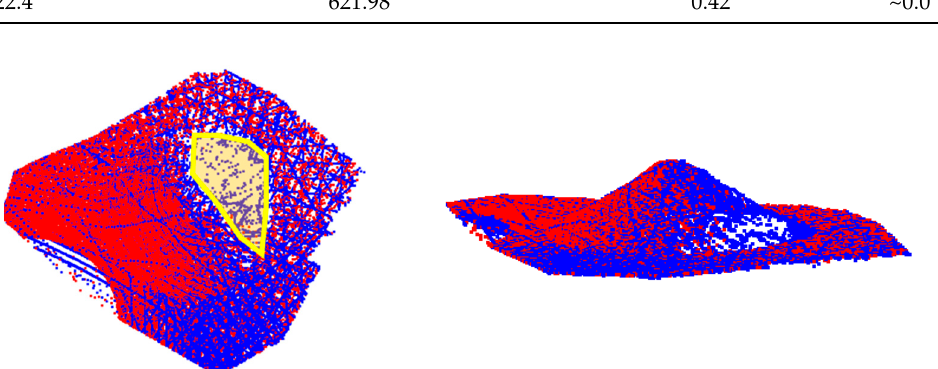
Figure 31. Point clouds for the right small pile in the Lebanon facility from TLS and SMART highlighted in red and blue, respectively. Top view ( left ), and side view ( right ). Table 7. SMART and TLS volumes estimates for post-repositioned stockpiles on the left side.